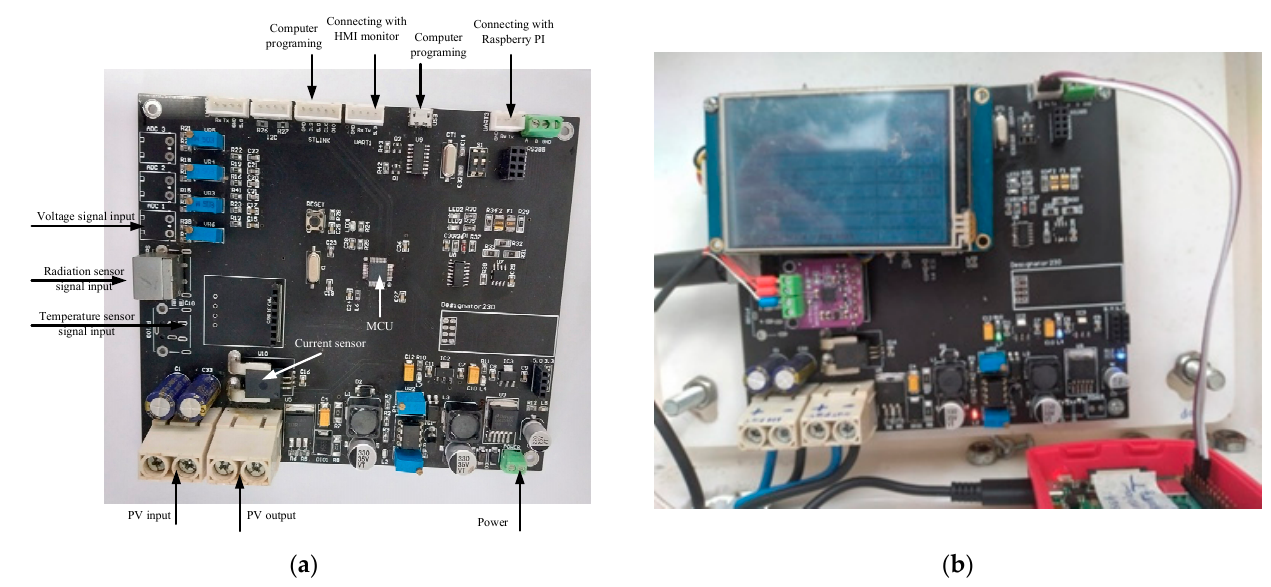
Figure 4. Photographs of proposed IoT-based PVEFD system: ( a ) mainboard; ( b ) connected with peripherals.